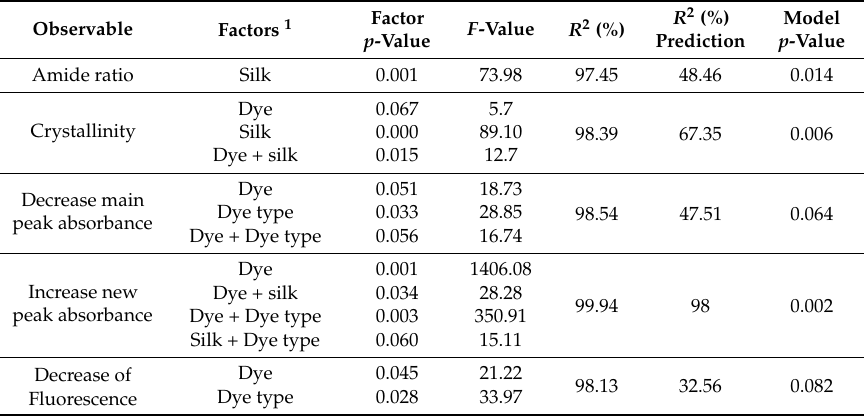
Table 2. Analysis of variance and regression results.